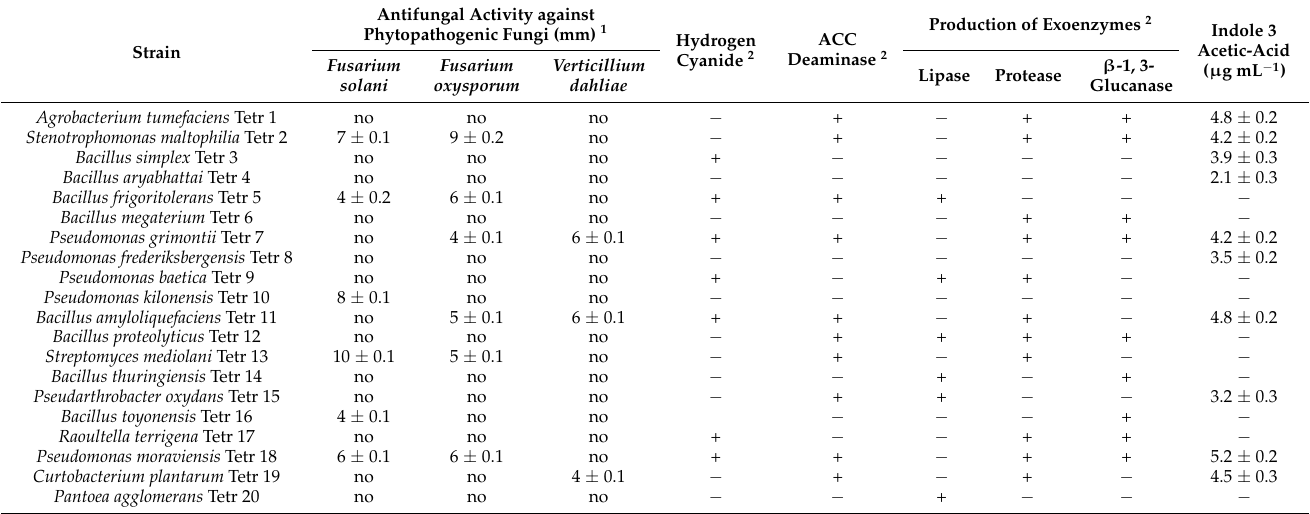
Table 3. Traits possibly involved in biocontrol and/or plant growth promotion by bacterial endo- phytes from Tetragonia tetragonioides (Pall.) O. Kuntze.